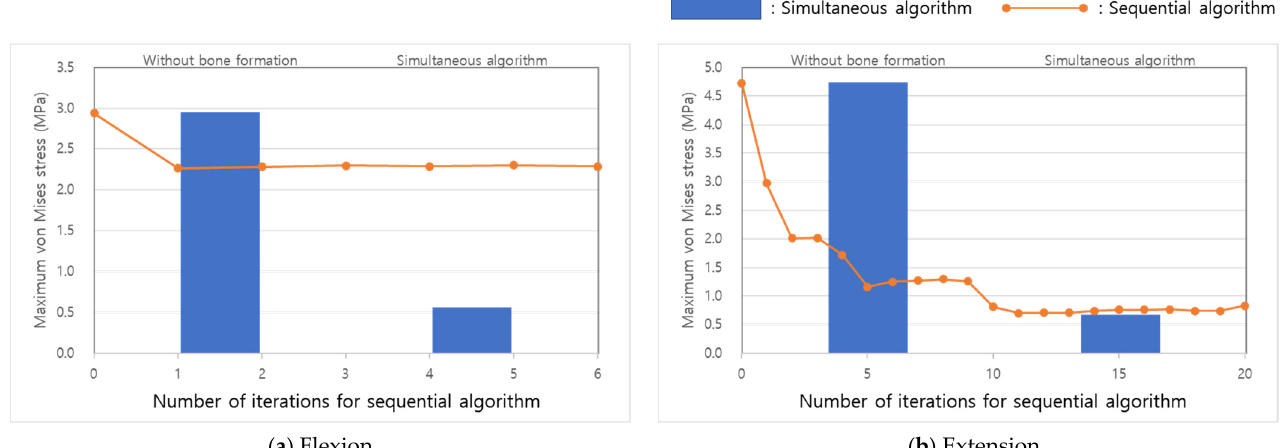
Figure 9. Changes in the maximum von Mises stress on the trabecular bone when simulating bone formation using two algorithms during ( a ) flexion and ( b ) extension.